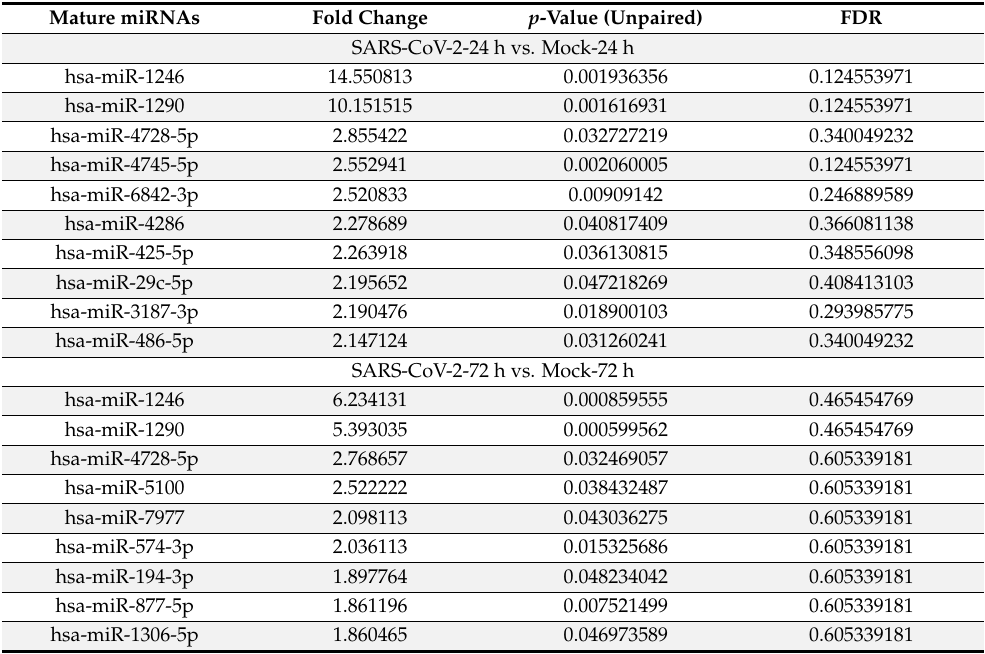
Table 1. Top 10 upregulated miRNAs in Calu-3 cells at 24 h and 72 h post-SARS-CoV-2 infection, compared with uninfected control (Mock).